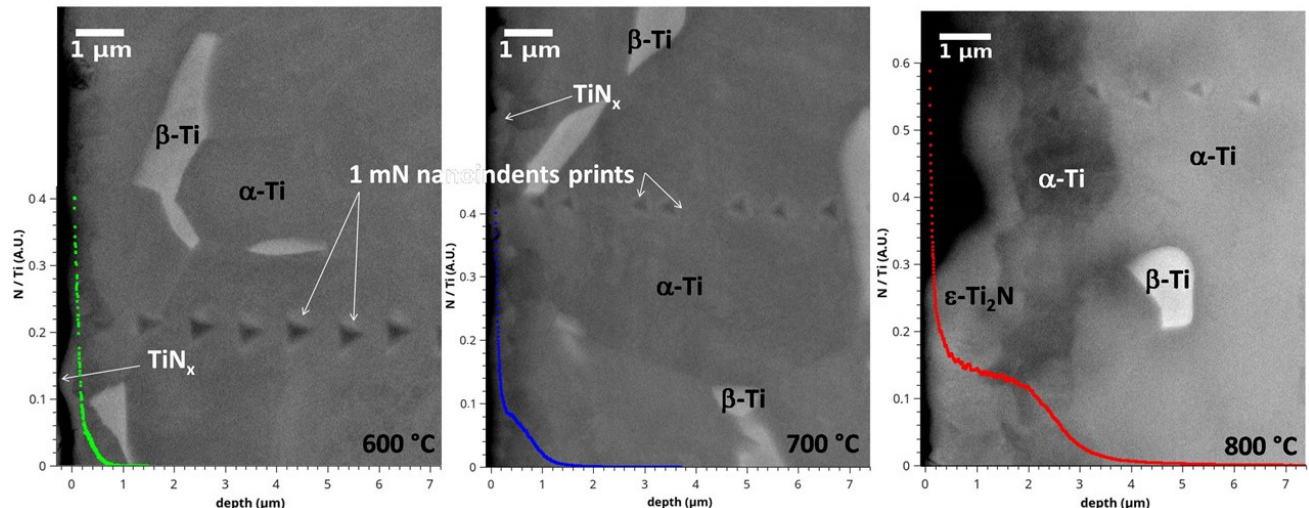
Figure 3. Cross-sectional SEM views after nanoindentation tests at 1 mN and N/Ti GDOES profiles of Ti-6Al-4V sample treated via PBII (25 kV, 200 Hz, 10 µs) for 240 min at either 600, 700 or 800 °C of Ti-6Al-4V sample treated via PBII (25 kV, 200 Hz, 10 µ s) for 240 min at either 600, 700 or 800 ◦ C in in a mixture of 90% N 2 –10% H 2 at 1 Pa. a mixture of 90% N 2 –10% H 2 at 1